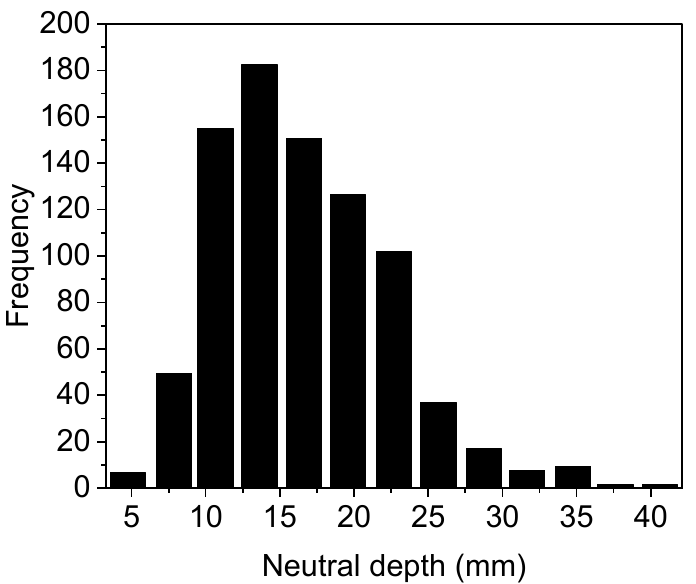
Figure 3. Histogram of neutral depth of concrete components of the Nanjing Yangtze river’s bridge. Table 2. The classification of neutralization depth.